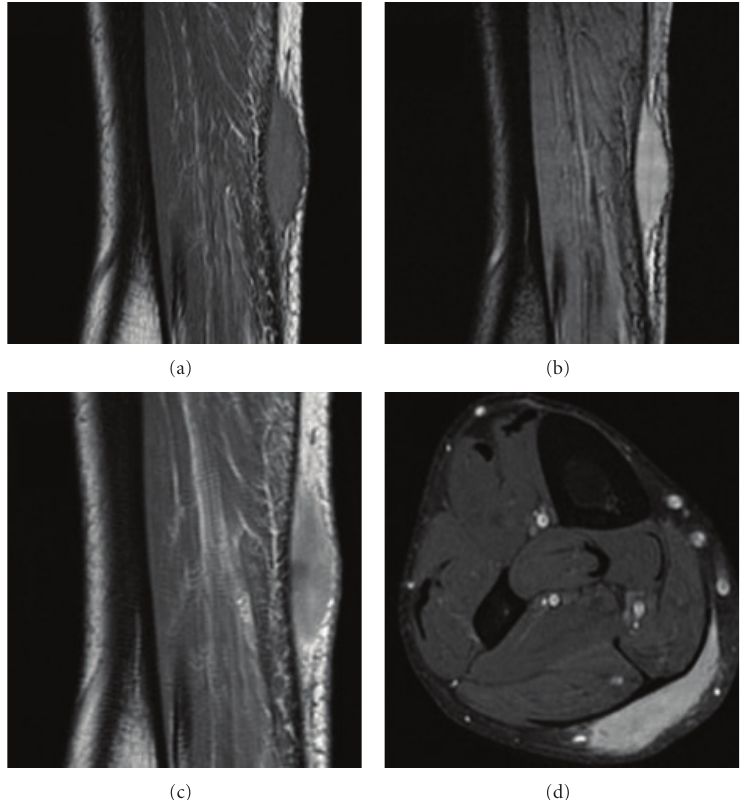
Figure 1: Sagittal T1 (a), T2 ∗ (b) weighted images depict a fusiform mass over the Achilles tendon. Postcontrast sagittal T1 (c) and axial fat-saturated T1-weighted images demonstrate a moderate and homogeneous enhancement.